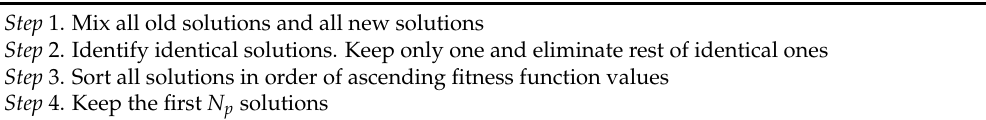
Table 2. The top solutions-based selection technique.